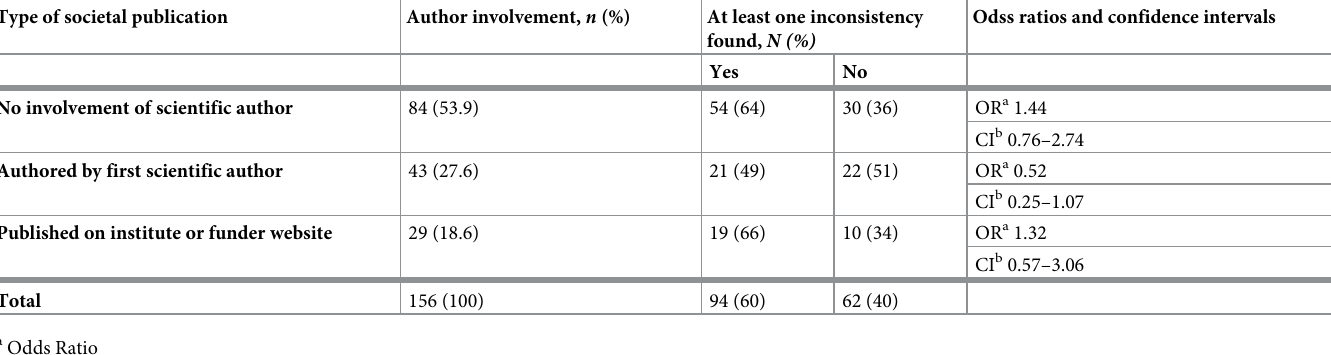
Table 2. The role of the first scientific author in the occurrence of inconsistencies between a societal and a scientific publication; odds ratio for each category (row) compared to both others ( N = 156). Type of societal